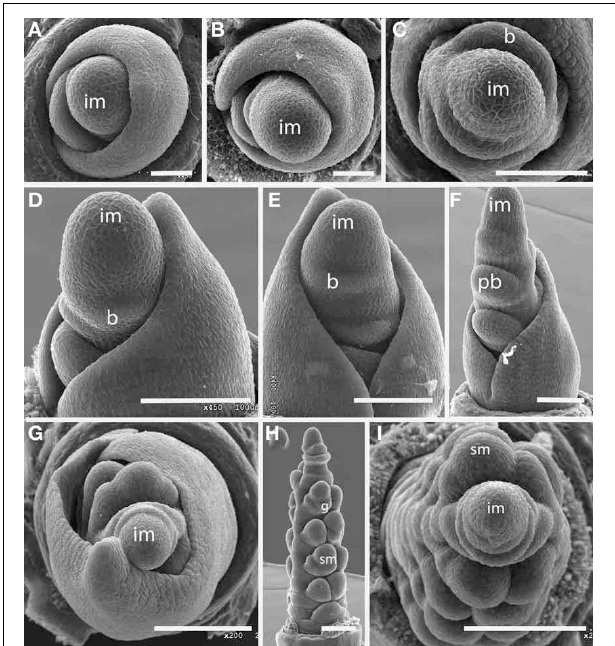
FIGURE 9 | Elymus hystrix (Triticeae). ( A–E ) Successive stages of distichous bract formation in the plane of the leaves; (F) initiation of primary branch meristems; (G–I) , differentiation of spikelet meristems. im, inflorescence meristem; pb, primary branch; b, bract, sm, spikelet meristem, g, glume. Scale bars: (A,B ), 50 µ m; ( C–F ), 100 µ m; ( G–I ), 200 µ m. converts into a spikelet meristem relatively early in development.